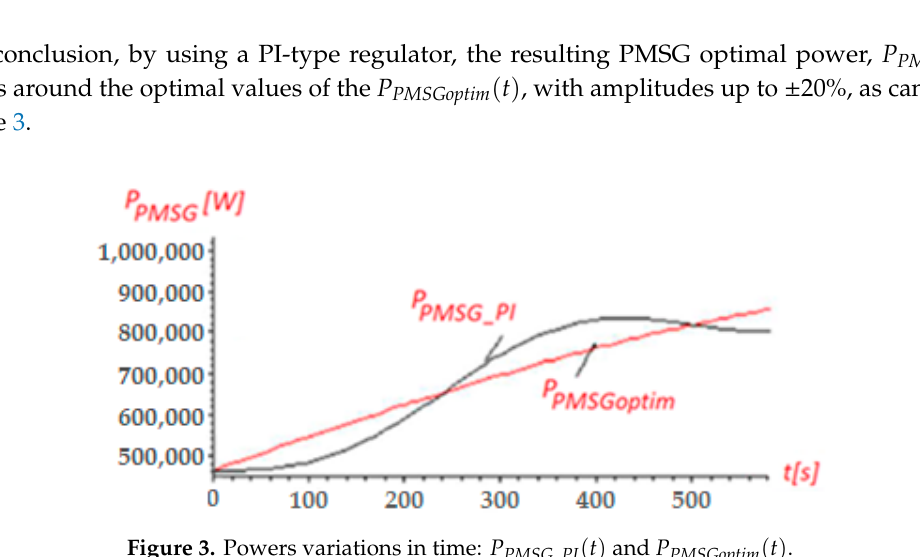
Figure (3). Powers variations in time: Figure 3. Powers variations in time: P PMSG _ PI ( t ) and P PMSGoptim ( t )